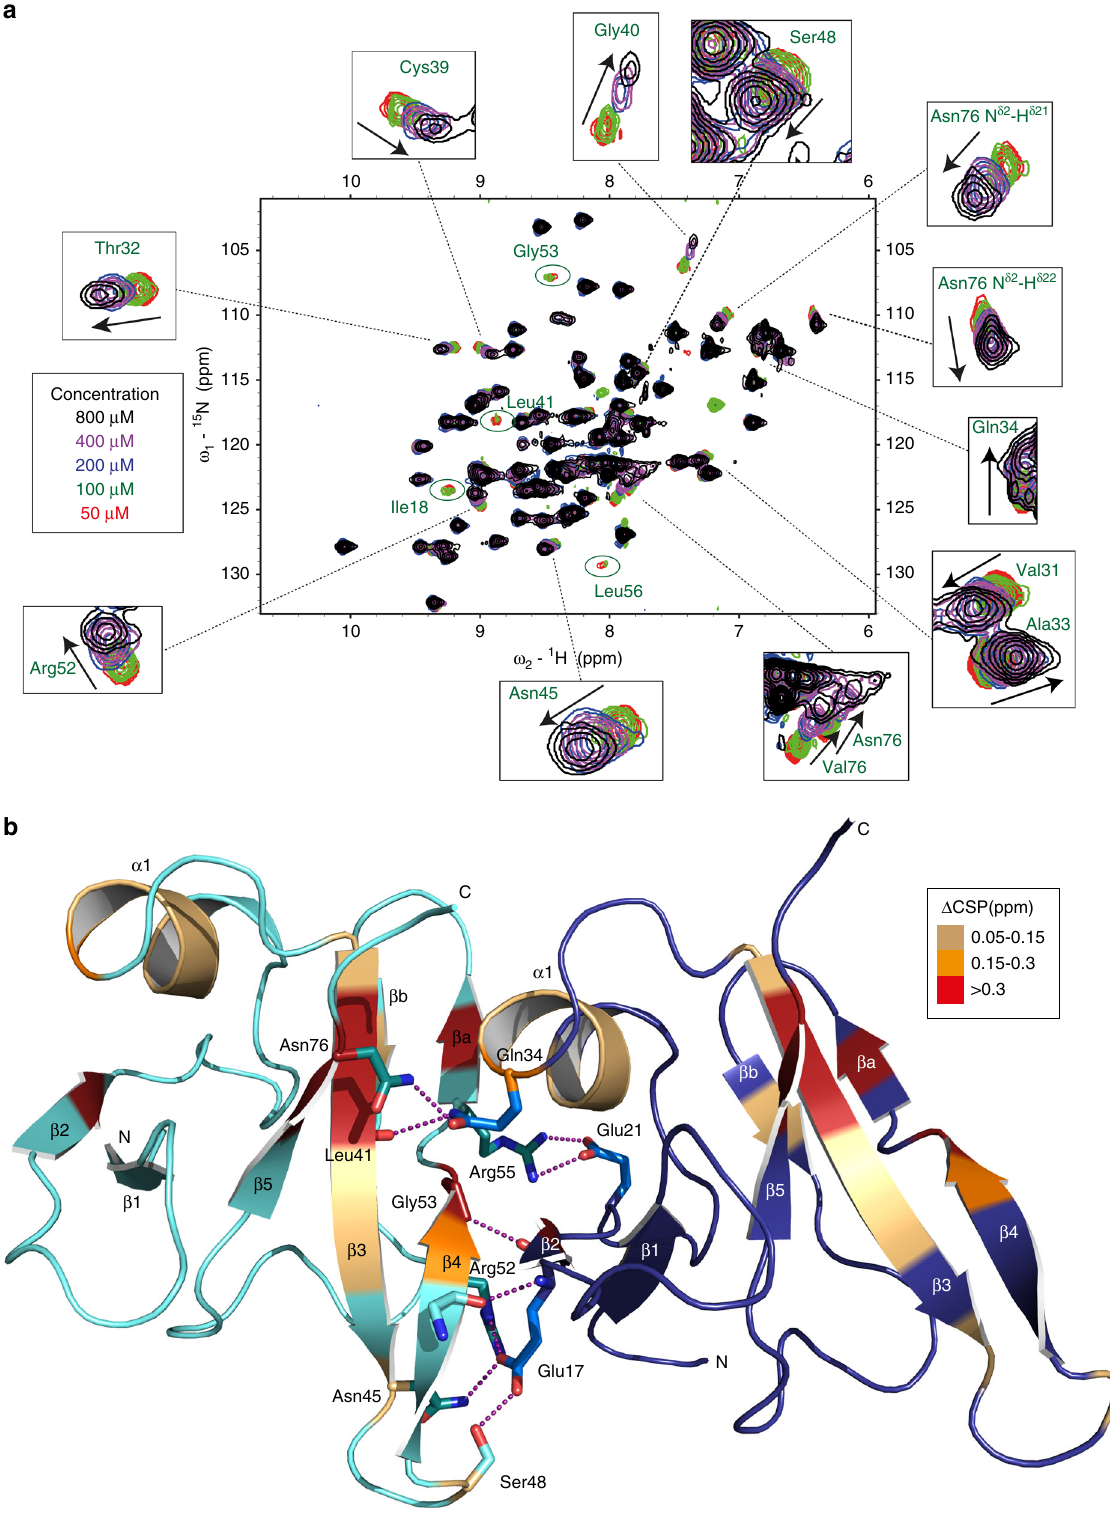
Fig. 3 TDP-43 NTD oligomerization analyzed by solution NMR spectroscopy. a Overlay of 2D 1 H- 15 N HSQC spectra at 30°C of 15 N isotopically labeled TDP-43 NTD at protein concentrations of 50, 100, 200, 400, and 800 μ M in red , green , blue , magenta , and black , respectively. Magni fi ed views of cross peaks undergoing chemical shift perturbations (CSP) are shown around the full spectra overlay while peaks showing line broadening are encircled in green and labeled. Black arrows show the direction of movement of the peaks. b Backbones of amino acids undergoing CSP are colored on the cartoon of TDP-43 NTD crystal structure. Relative to the lowest protein concentration (50 μ M), the changes in average chemical shift perturbations ( Δ CSP = Δ (( δ H) 2 +( δ N/5) 2 )/2) 1/2 , in which δ H and δ N are in ppm) were calculated at highest protein concentration (800 μ M) and colored on the structure based on the magnitude of perturbations as indicated. Side chains contributing to inter-molecular interface seen in the crystal structure are displayed as sticks with H-bonds in